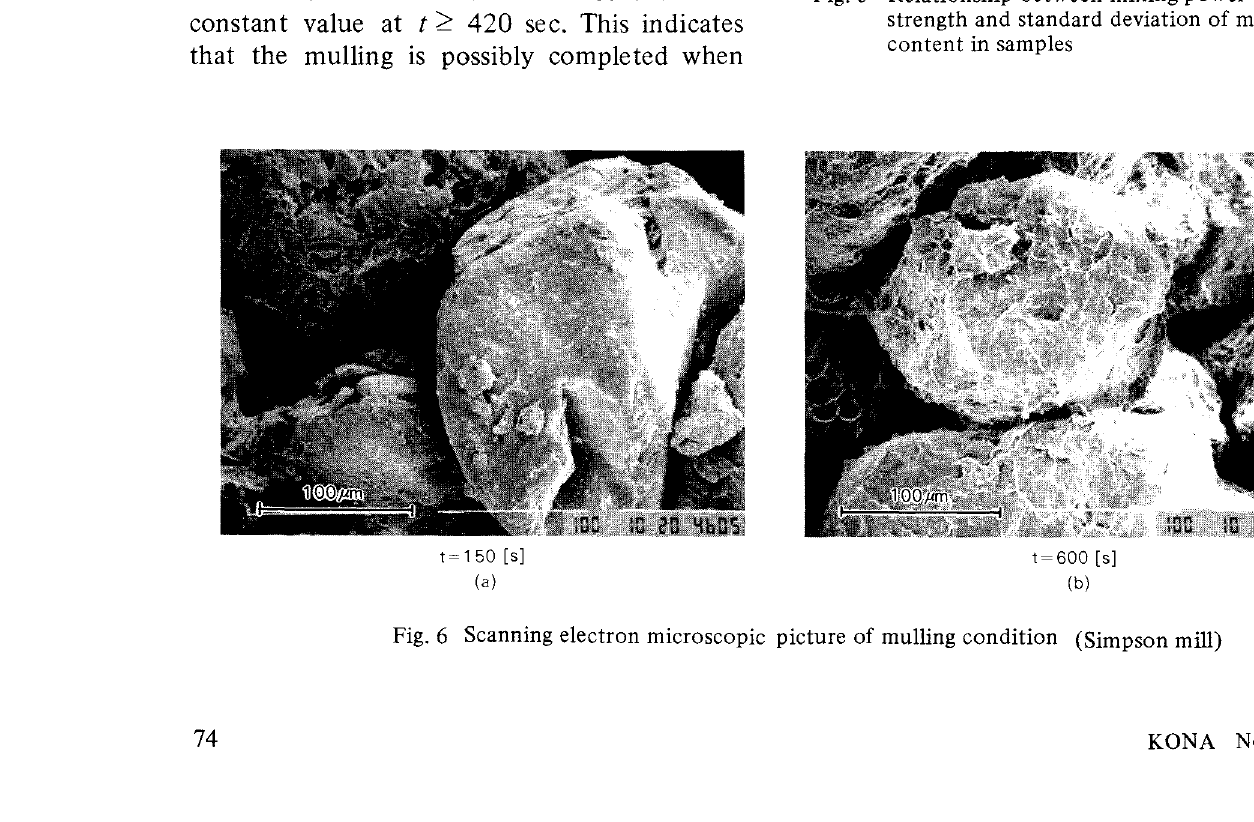
Fig. 5 Relationship between mixing power and tensile strength and standard deviation of moisture content in samples